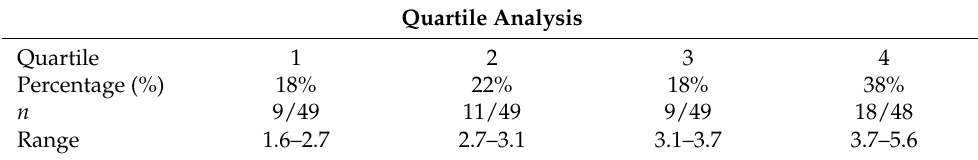
Table 4. FSTL1 quartile expression. Baseline FSTL1 mRNA levels divided into quartiles. Quartile